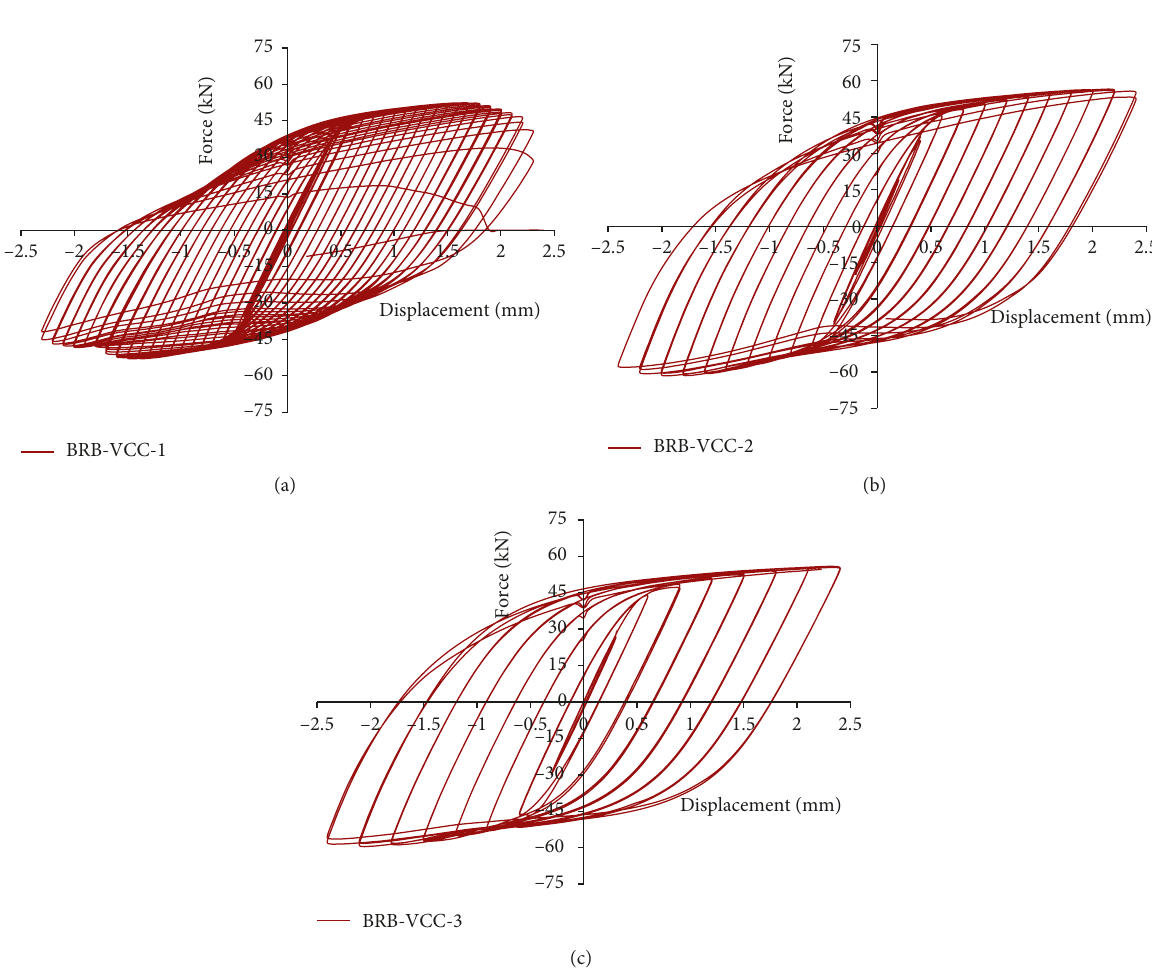
Figure 9: BRB-VCC-1 after test. (a) Core. (b) Restraining tube.